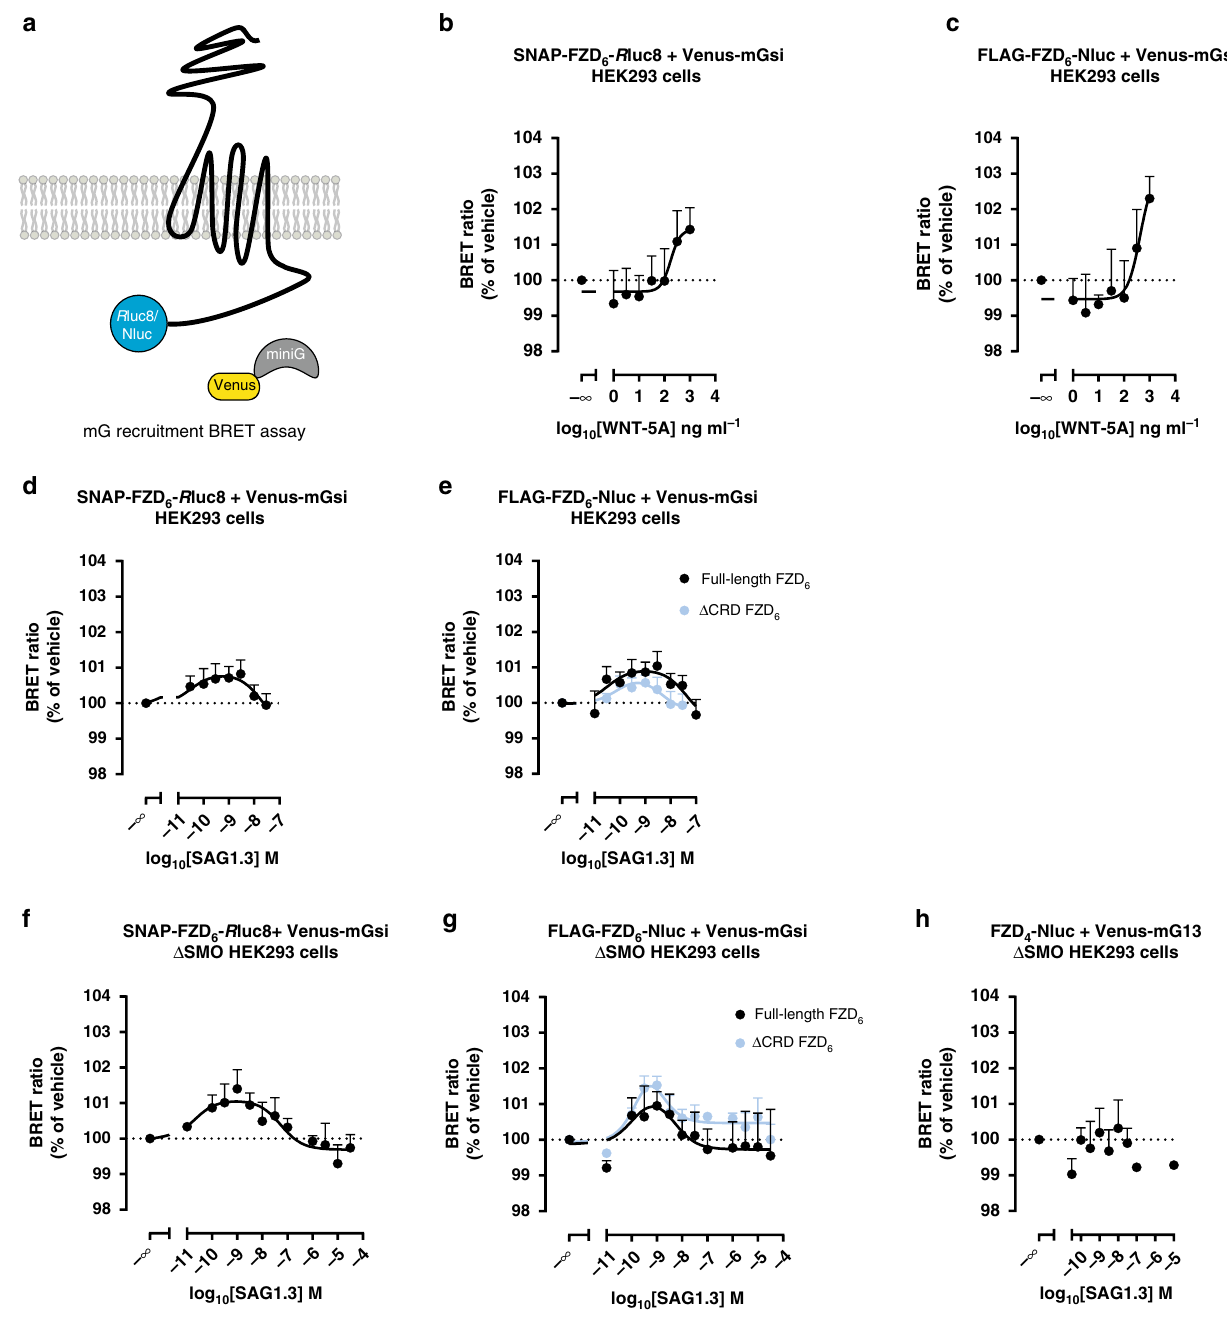
Fig. 4 SAG1.3 mediates recruitment of mGsi proteins to FZD 6 . a The scheme depicts the experimental set up of BRET analysis between the luciferase- tagged FZD 6 and the Venus-tagged mGsi. Ligand stimulation initiates the mG protein recruitment to the receptor resulting in the increase of BRET. WNT- 5A induced a concentration-dependent recruitment of the Venus – mGsi to SNAP – FZD 6 – R luc8 ( b ; total n = 4 individual experiments) and FLAG – FZD 6 – Nluc ( c ; total n = 3 individual experiments) in transiently transfected HEK293 cells. SAG1.3 induced a bell-shaped, concentration-dependent recruitment of the Venus – mGsi to SNAP – FZD 6 – R luc8 ( d ; n = 10 individual experiments), FLAG – FZD 6 – Nluc or Δ CRD FLAG – FZD 6 – Nluc ( e ; total n = 11 individual experiments for FLAG – FZD 6 – Nluc, and total n = 8 individual experiments for Δ CRD FLAG – FZD 6 – Nluc) in transiently transfected HEK293 cells. f Similar experiments were performed in HEK293 lacking endogenous SMO ( Δ SMO HEK293 cells). SAG1.3 showed concentration-dependent effects on SNAP – FZD 6 – R luc8 ( f ; total n = 11 individual experiments), FLAG – FZD 6 – Nluc ( g ; total n = 10 individual experiments) and Δ CRD FLAG – FZD 6 – Nluc-transfected ( g ; total n = 8 individual experiments) Δ SMO HEK293 cells. h SAG1.3 did not evoke Venus – mG13 recruitment to FZD 4 – Nluc, which is consistent with the in silico prediction (total n = 4 individual experiments). All BRET data are presented as mean ± s.e.m. Source data are provided as a Source Data fi